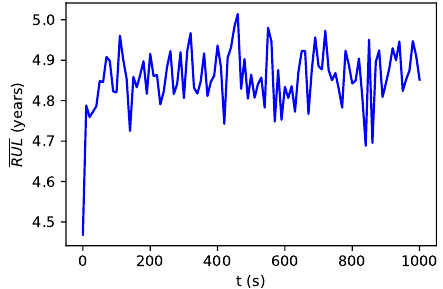
Figure 11. RUL corresponding to the MPC simulation (Figure